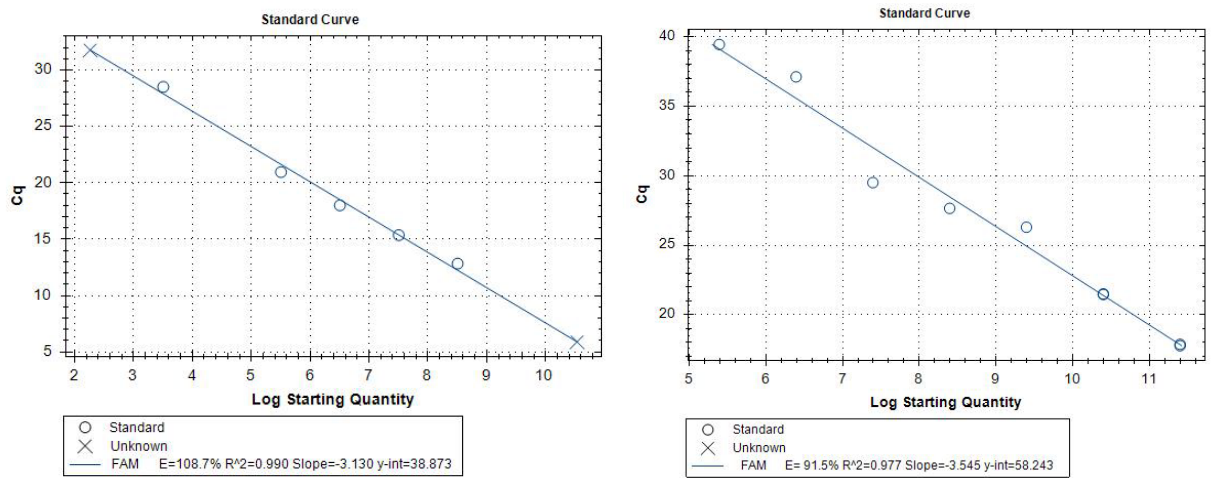
Figure 1. Standard curves for AlmWB phytoplasma plasmid (A); and for total nucleic acids (TNAs) extracted from healthy almond (B).